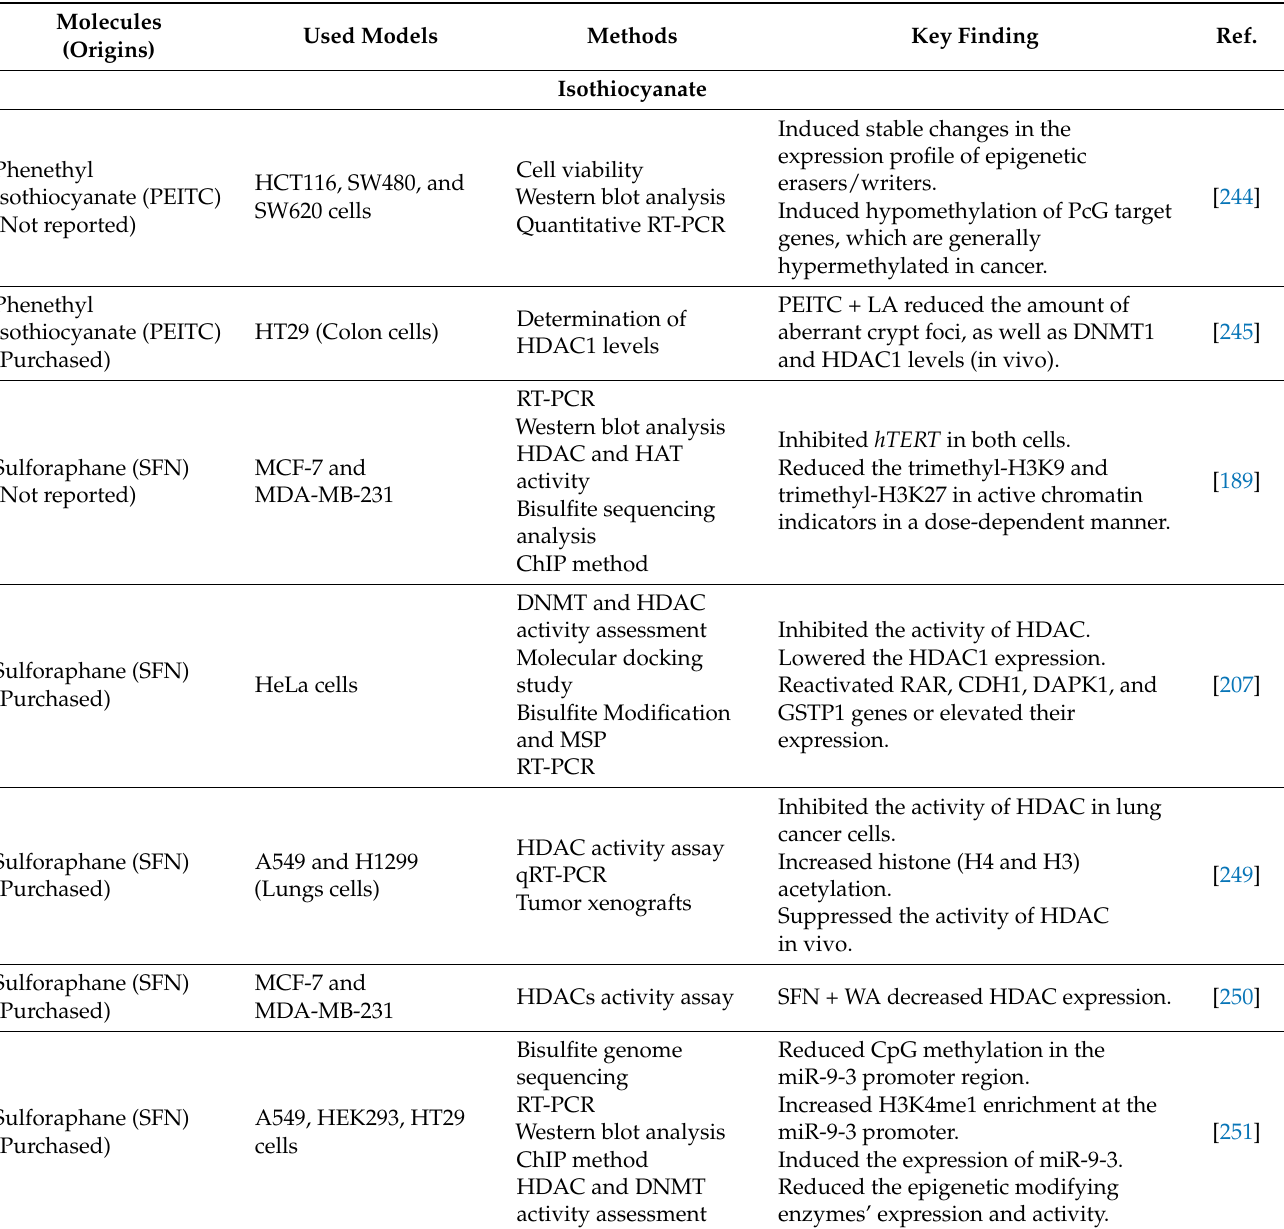
Table 5. Other natural molecules targeting HDAC in human